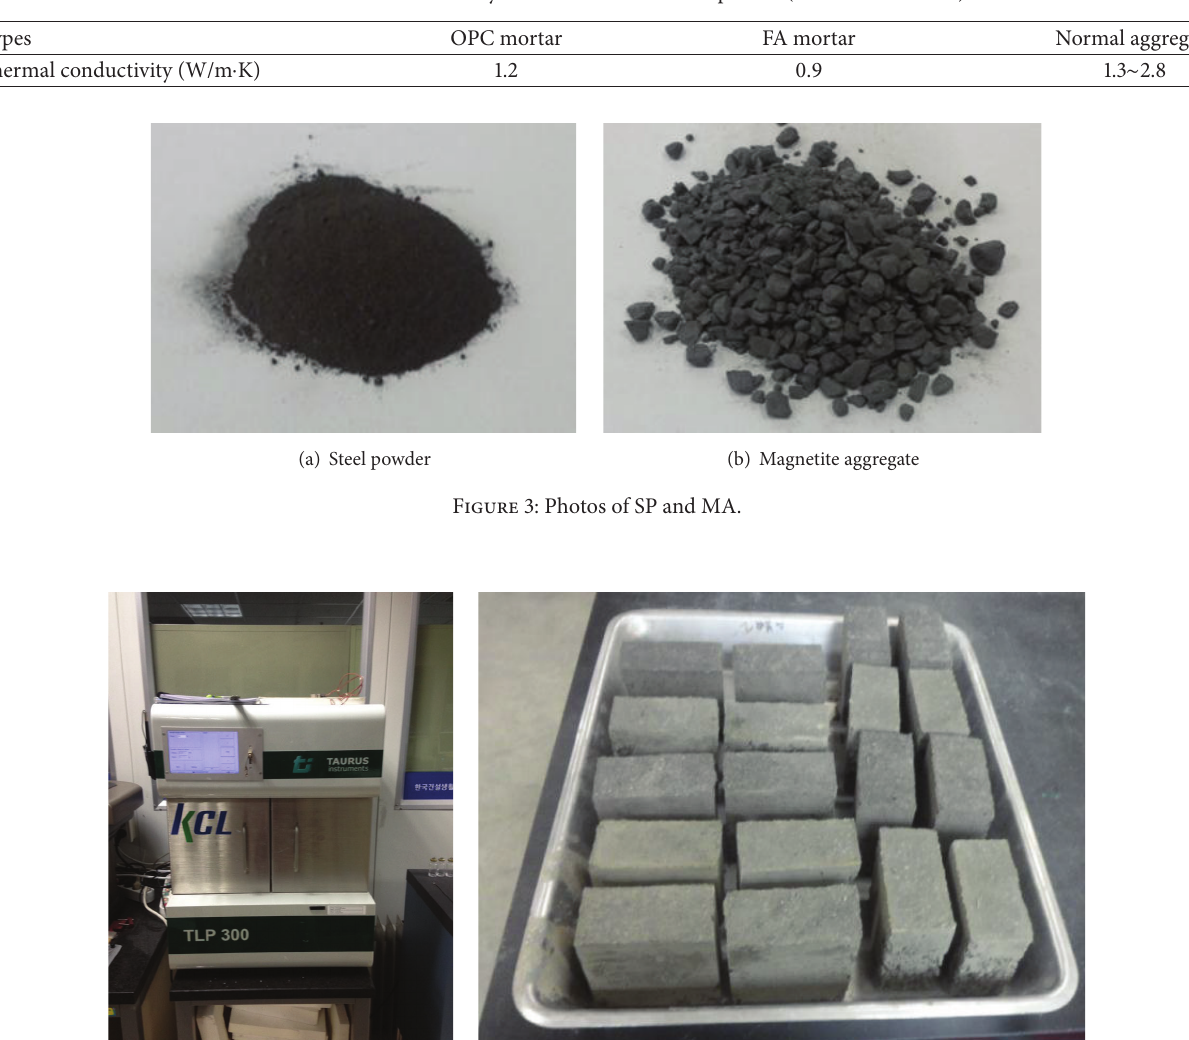
Table 5: Thermal conductivity in normal concrete component (in room condition).